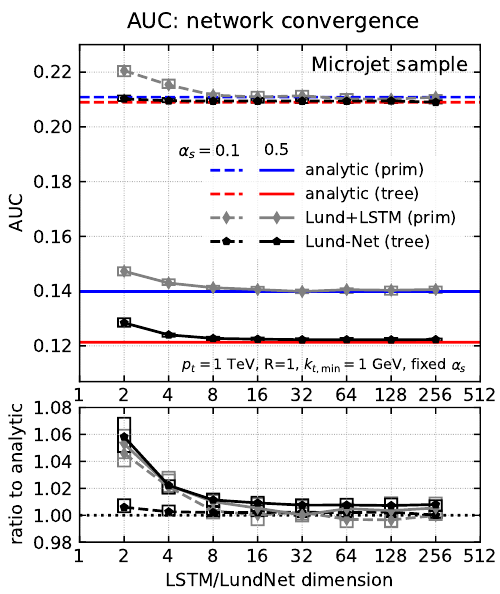
Figure 3. Area under the ROC curve (AUC) as a function of dimension of the network. The networks converge to the optimal (analytic) discriminant above ≈ 32 nodes, proving that the networks learned all the features of the microjet